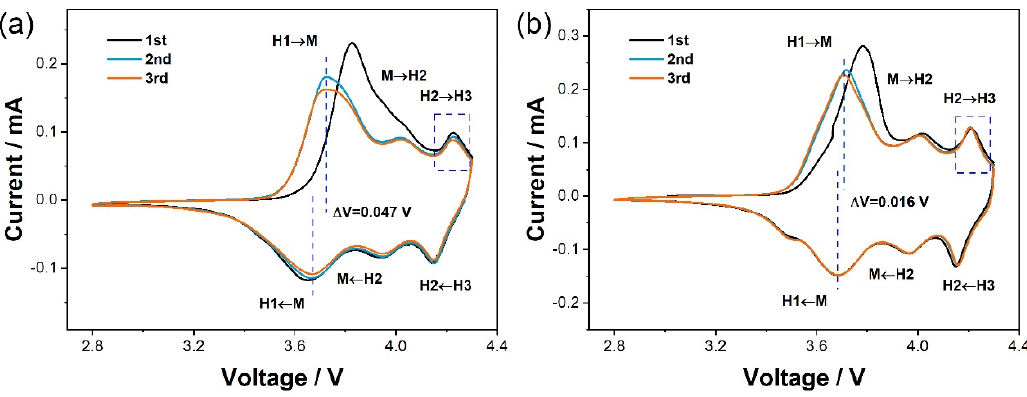
Figure 6. CV of ( a ) NCA, ( b ) W1.0 - NCA.